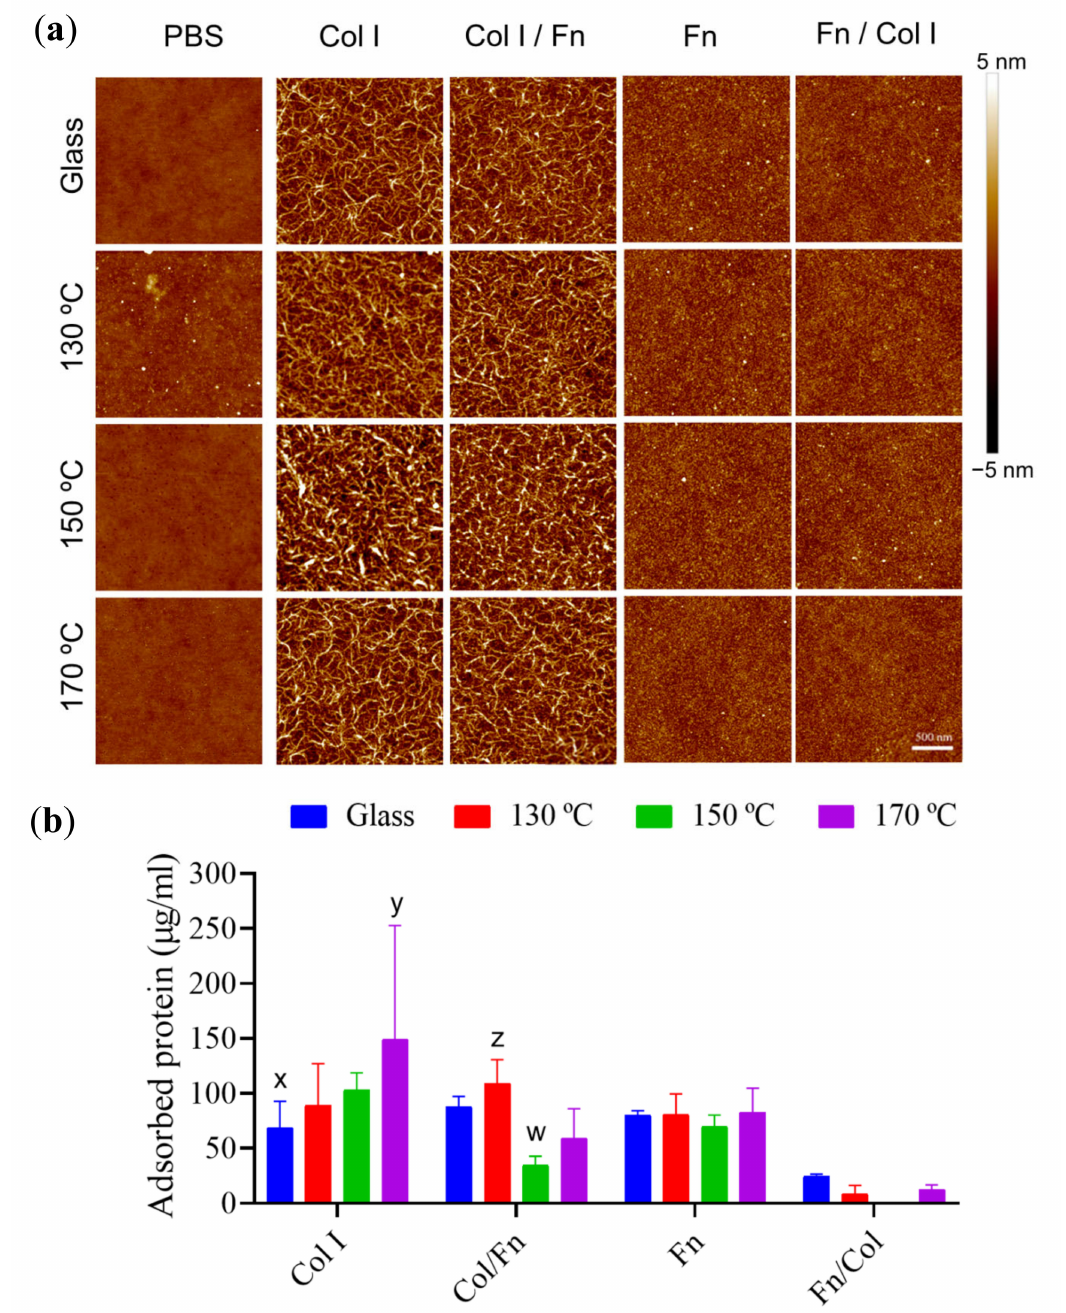
Figure 4. Sequential protein adsorption on PGS substrates. ( a ) Atomic force microscope (AFM) height images of 2 × 2 µ m 2 and ( b ) protein adsorption quantification from microBCA colorimetric technique with single protein (Fn 100 µ g/mL or Col I 400 µ g/mL) and sequential adsorption assays of Fn and Col I (Fn 100 µ g/mL+ Col I 80 µ g/mL), and vice versa (Col I 400 µ g/mL + Fn 20 µ g/mL) on PGS cured at different temperatures. The first column in ( a ) shows the presence of PGS on the glass with no major difference in height for any of the applied curing temperatures. All images share the 500 nm scale bar. Glass covers without spin-coated PGS are shown in ( b ) as control. Sample data distributions were analysed through two-way ANOVA and a Bonferroni post hoc multiple mean comparison test, with a p -value of